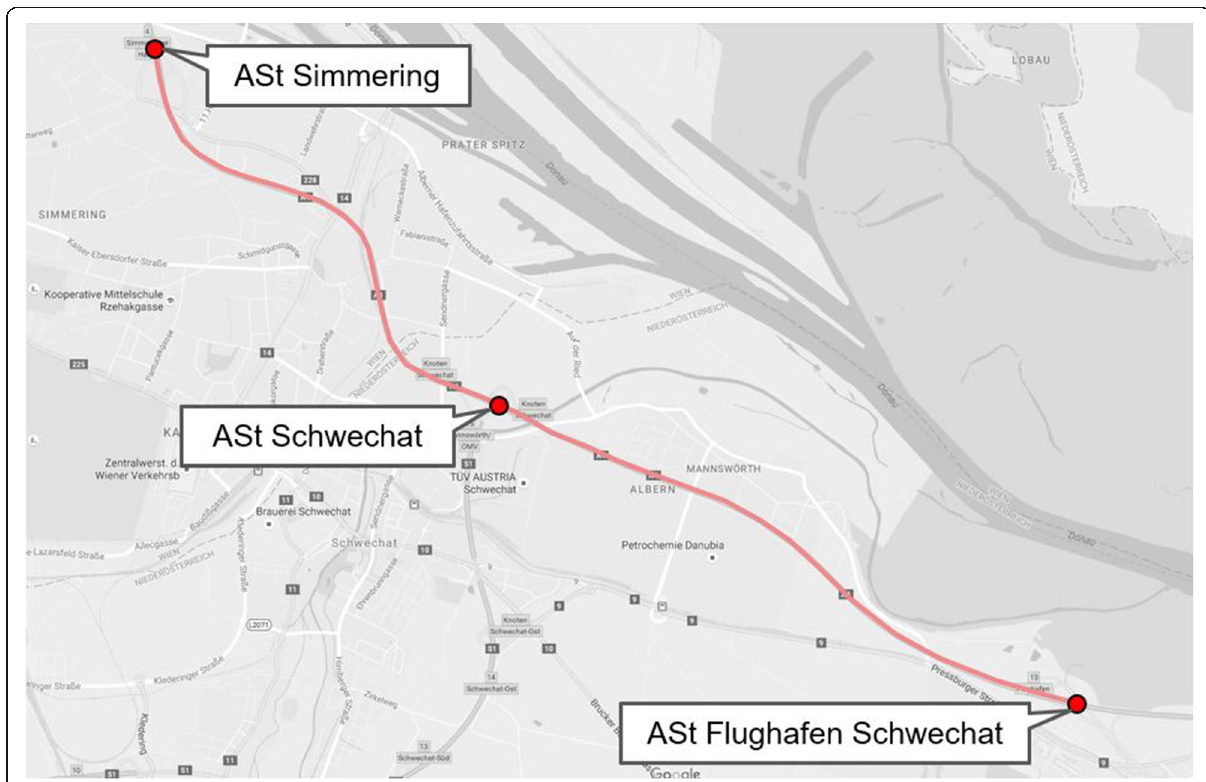
Fig. 5 Targeted road section on the A4 Ost Autobahn (East